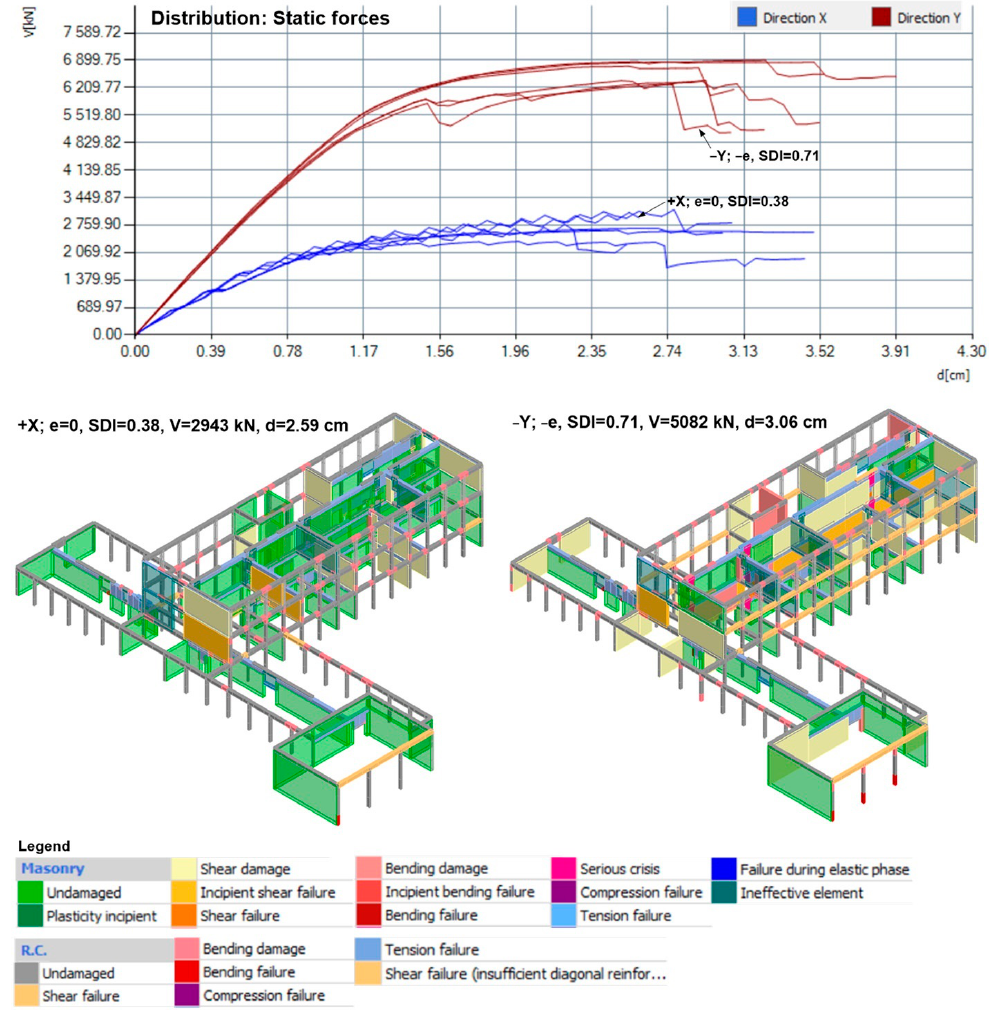
Figure 21. EFM results: pushover curves and corresponding damage mechanism of the building obtained using the static forces load pa tt erns.